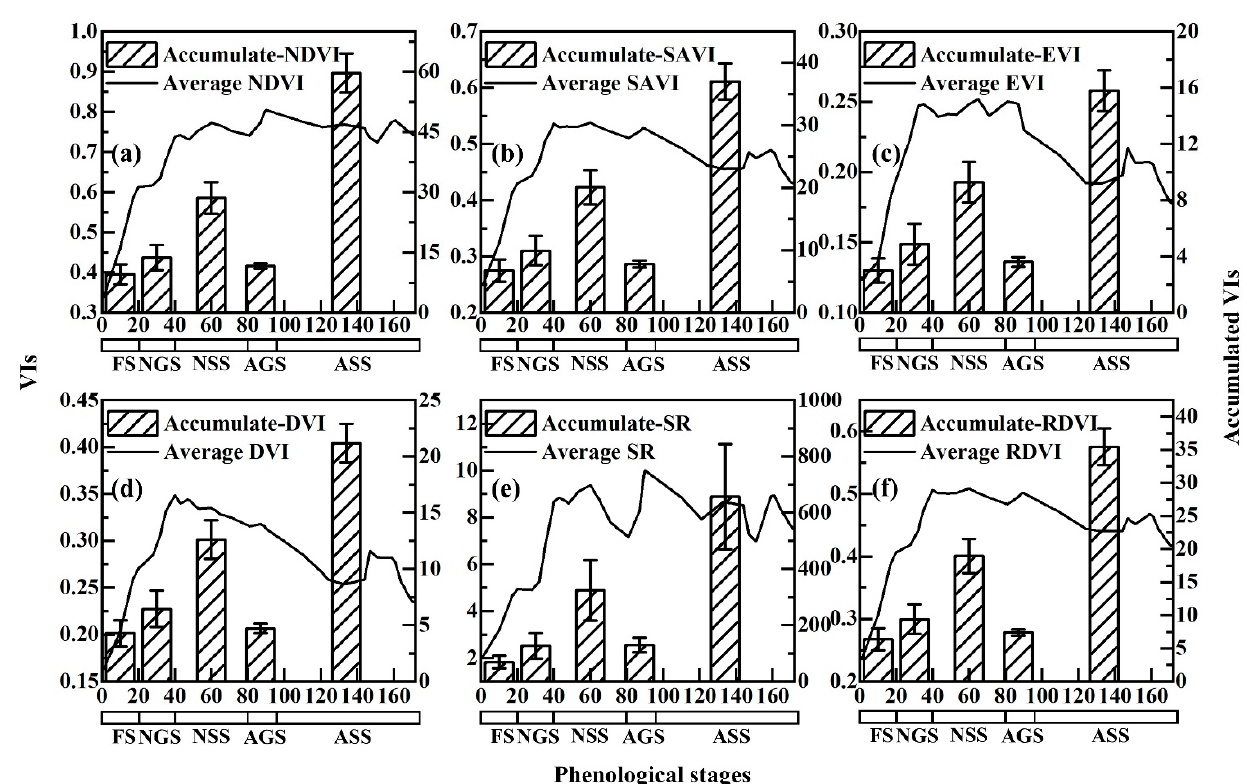
Figure 4. The trends of six VIs and ∑ VIs for apple trees during the whole growth period: ( a ) NDVI, ( b ) SAVI, ( c ) EVI, ( d ) DVI, ( e ) SR, and ( f ) RDVI. Table 3. Correlation analysis between yield and ∑ Vis at different phenological stages.